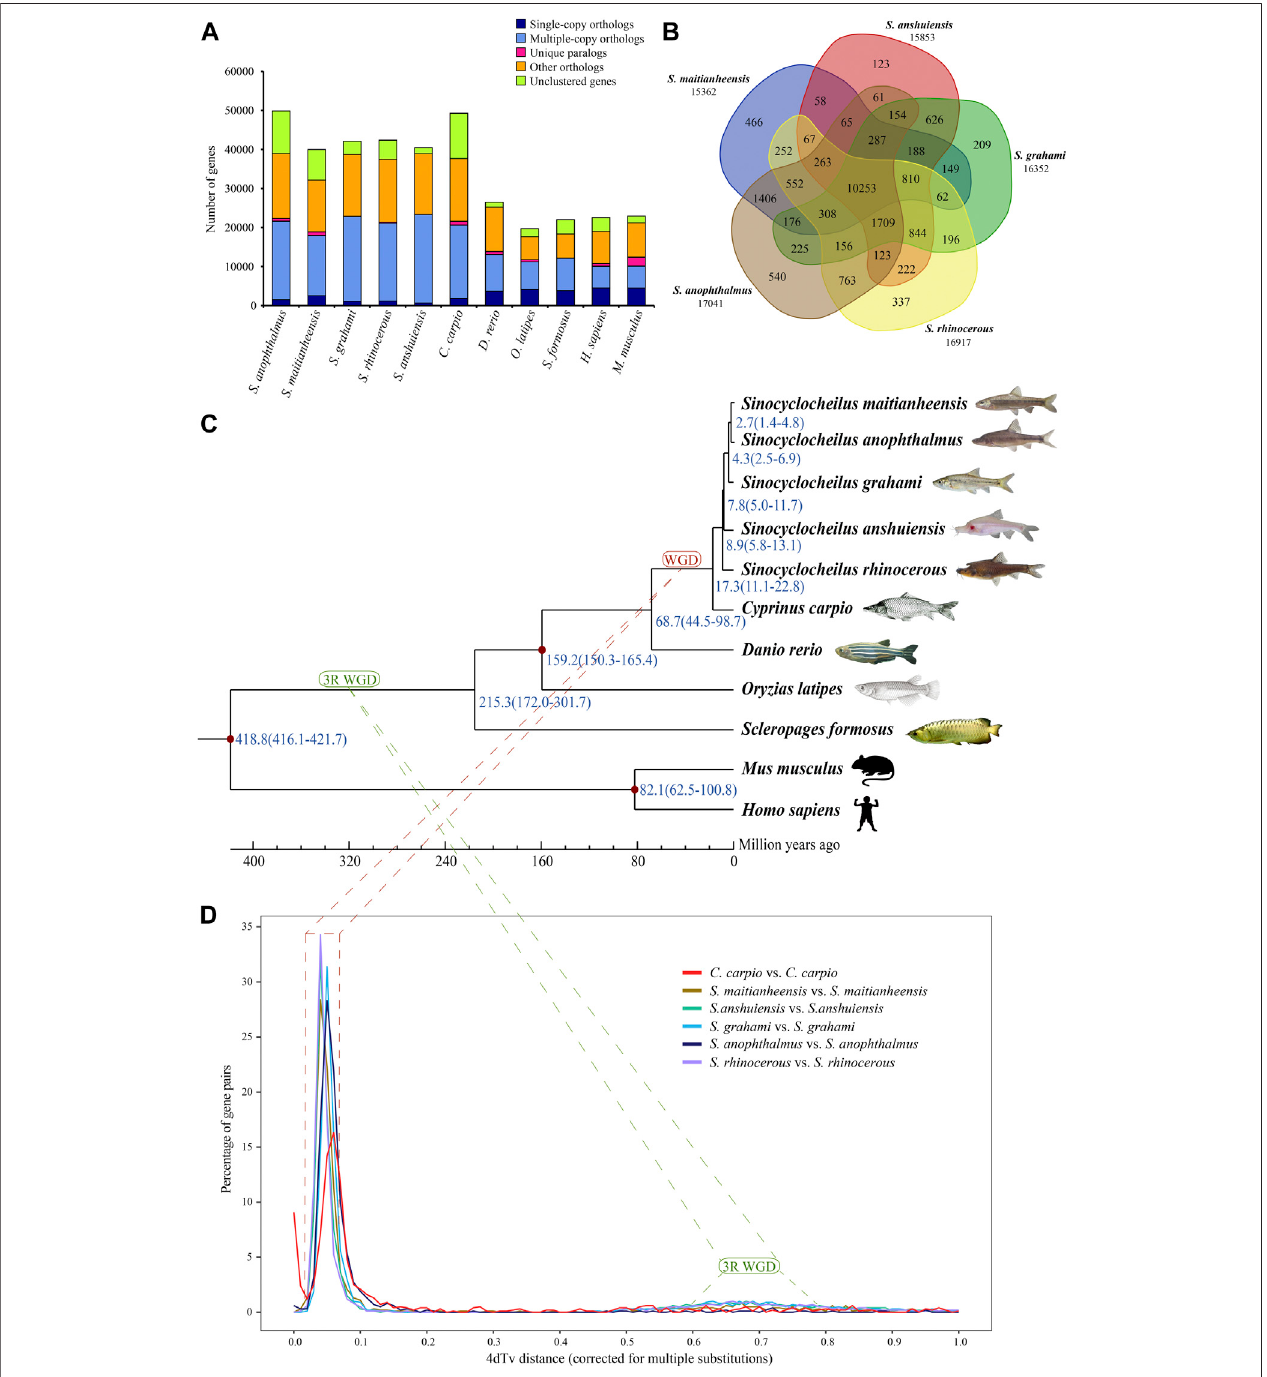
FIGURE 1 | Orthogroups and an evolutionary analysis. (A) Distribution of homologous orthogroups among the examined 10 vertebrate species. (B) Orthogroup cluster of the fi ve Sinocyclocheilus fi shes, including S. maitianheensis , S. anophthalmus , S. grahami , S. anshuiensis , and S. rhinocerous . (C) A phylogenetic tree of variousrepresentativevertebratesincludingthe fi ve Sinocyclocheilus fi shes.Divergetimeisrepresentedinblue,andthegeographictimescaleisinmillionyears(forMya). “ WGD ” represents the Sinocyclocheilus -speci fi c WGD event (red), and “ 3R WGD ” represents the third-round WGD event (green). (D) 4dTv distributions of self- alignments in fi ve Sinocyclocheilus fi shes, and common carp.